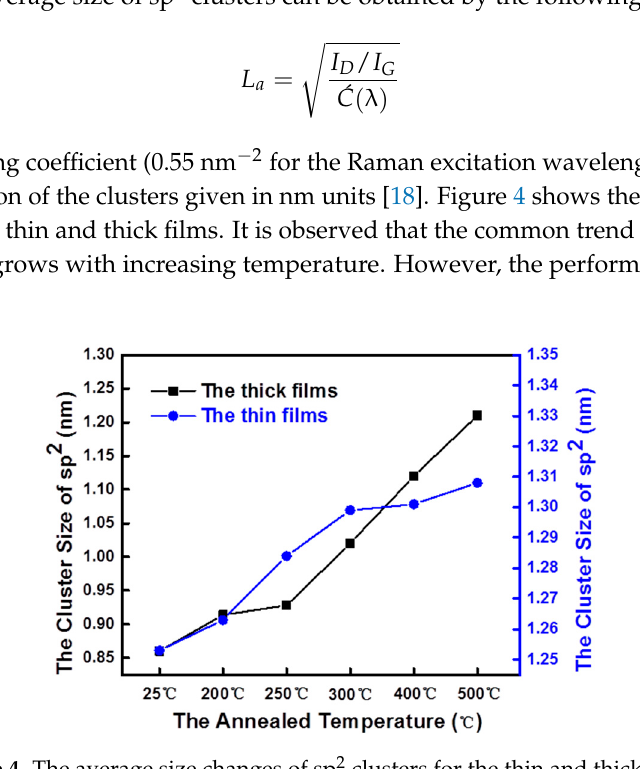
Figure 4. The average size changes of sp 2 clusters for the thin and thick films